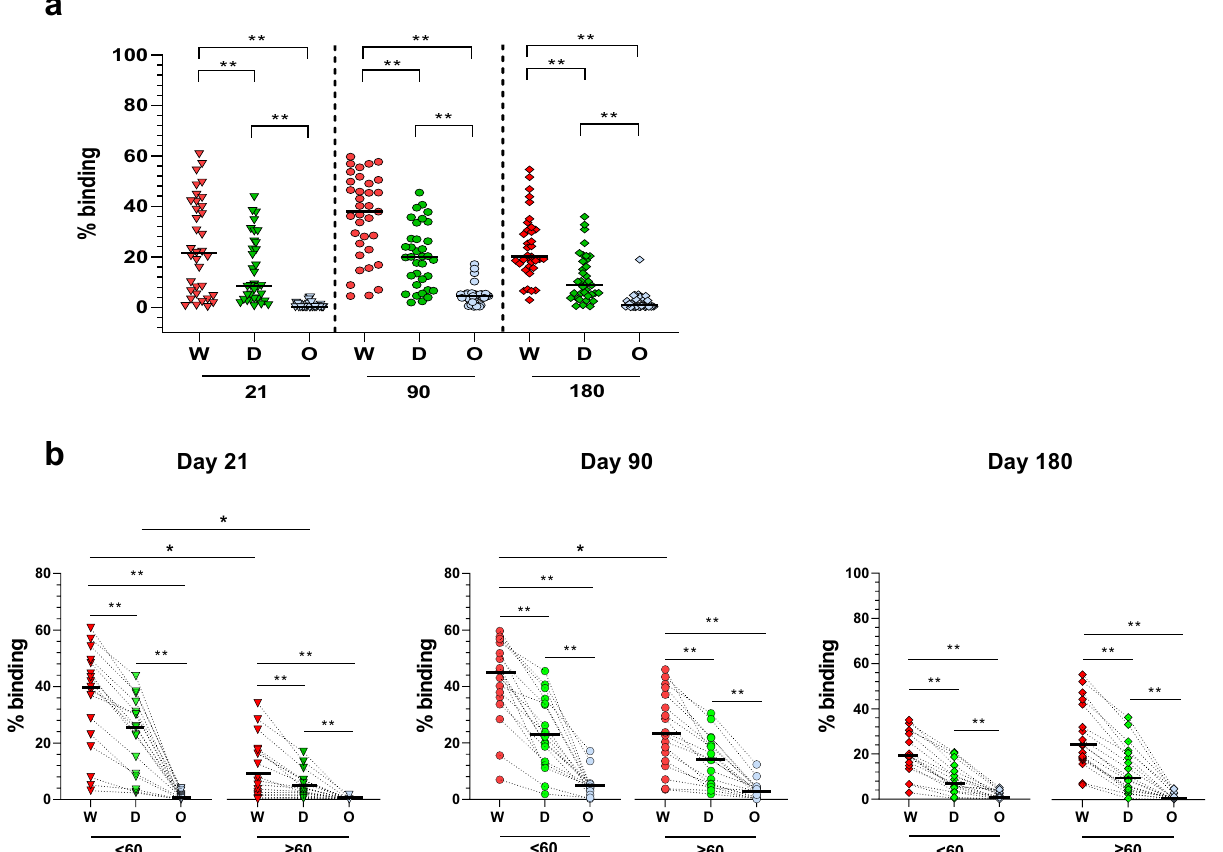
Fig. 3 | Antibody recognition of Wuhan ancestral strain, Delta and Omicron variants. a Comparison of antibody response of the vaccinees ( n =35) at days 21, 90 and 180 using the SFB assays with cells expressing either the Wuhan ancestral virus(W),thedelta(D)orOmicron(O)variantsoftheSpikeprotein.Medianvalues ofthesampleswereatday21,90and180respectively39.8%,37.9%and20.2forthe Wuhan strain; 8.45%, 20% and 8.8% for Delta;0.13%, 4.5% and 1.1% for Omicron. ** p <0.001,two-sidedMann – Whitneytest. b Comparisonbetweenagegroups:<60 ( n =17) and ≥ 60 ( n =18), at different time points (days 21, 90 and 180) using SFB withcellsexpressingeitherthewild-typeWuhanancestralvirus(W)orthedelta(D)